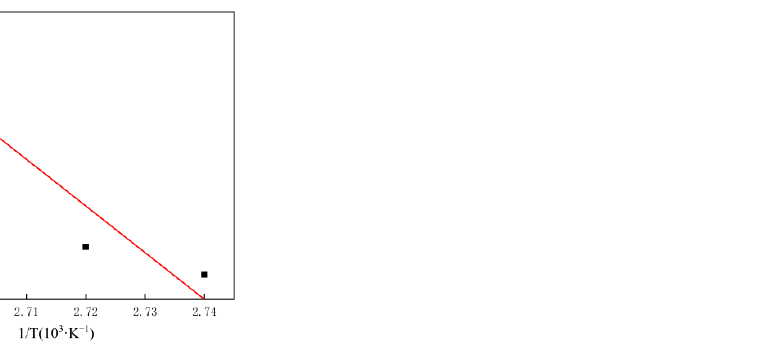
Figure 5. Arrhenius plots of the growth process for the α -HH samples synthesized by the hydro- thermal